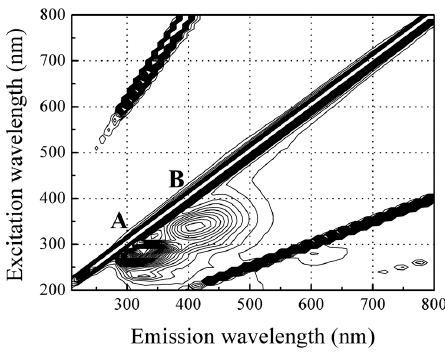
Figure 3. Typical front ‐ face fluorescence landscape of the red sea bream scale.